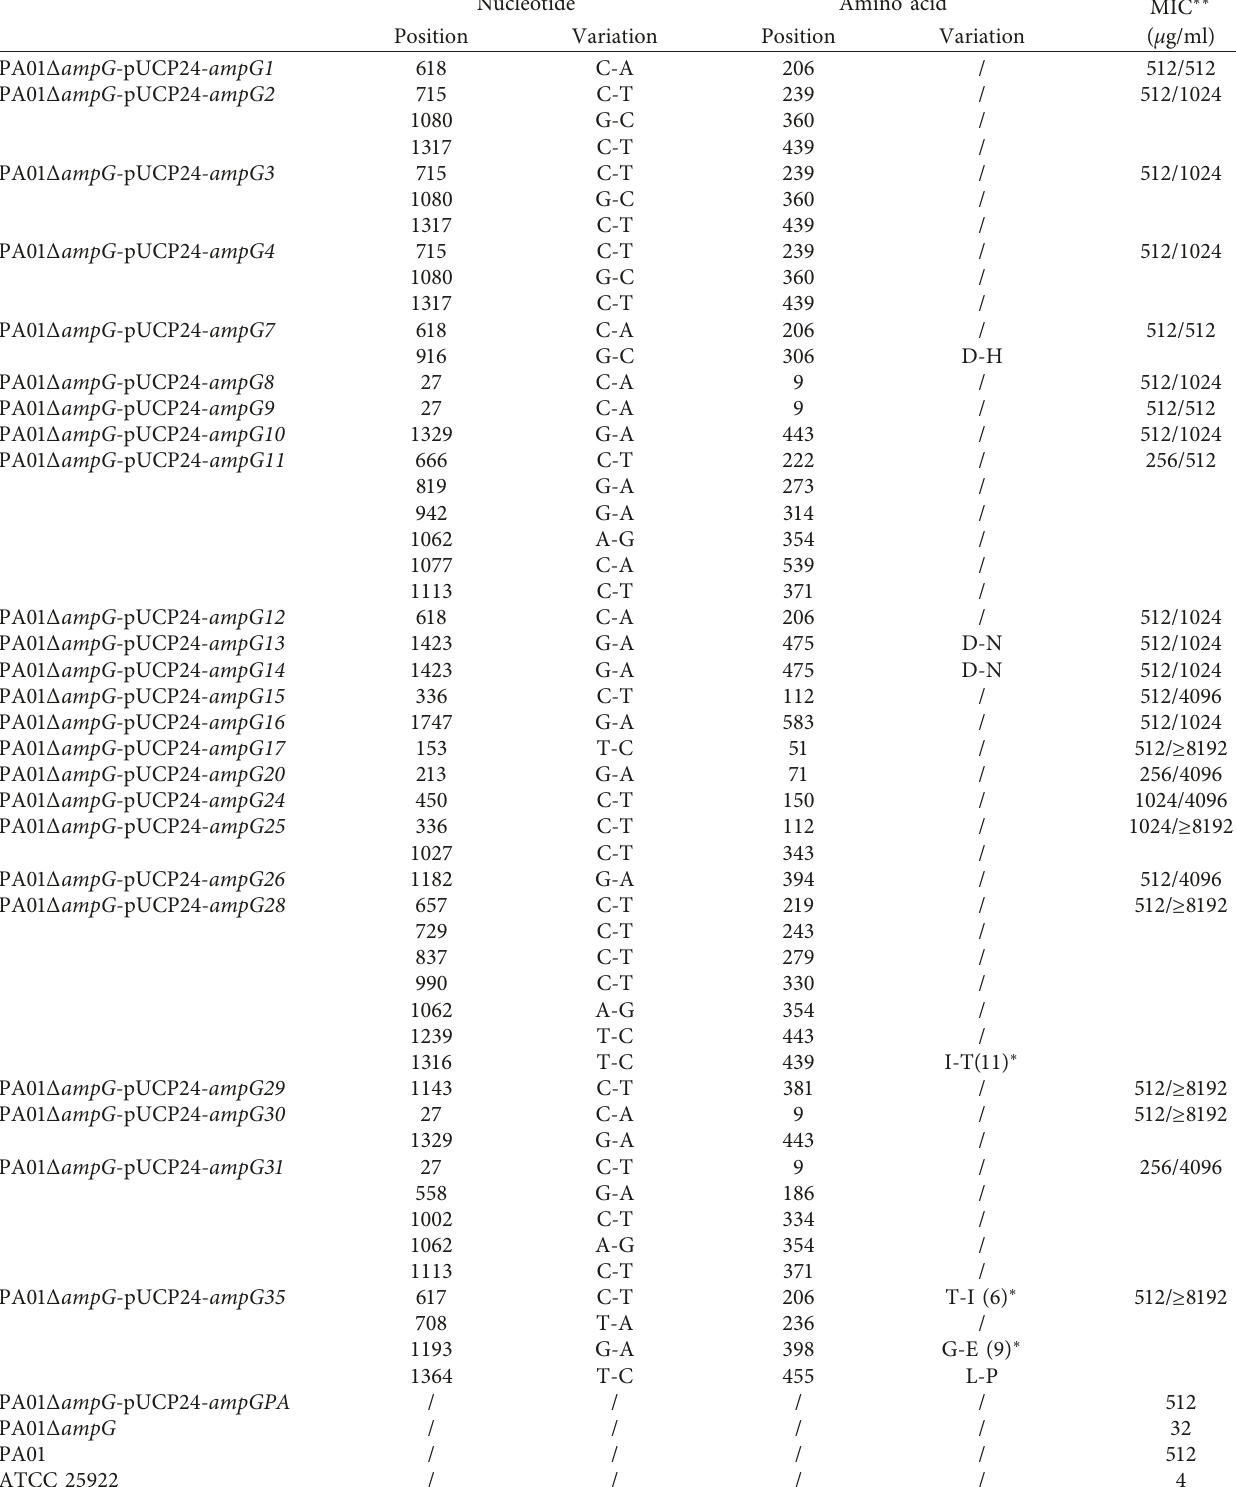
Table 3: Sequence variation and function of ampGs in clinical P. aeruginosa